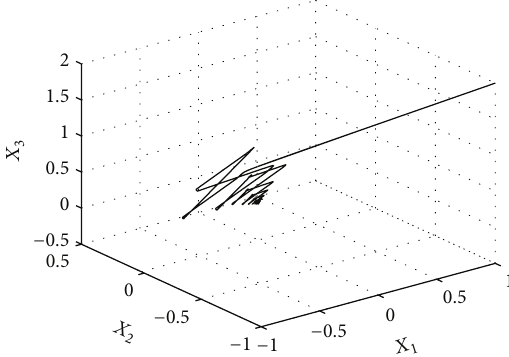
Figure 5: Phase plane trajectory of the three control